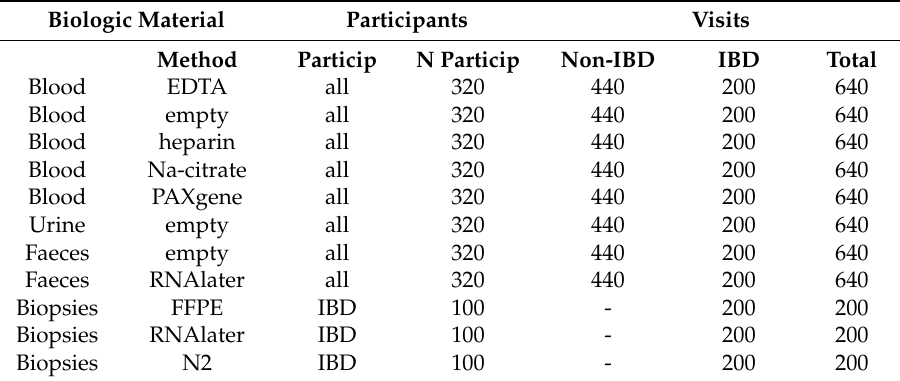
Table 2. Overview of biological samples available for this